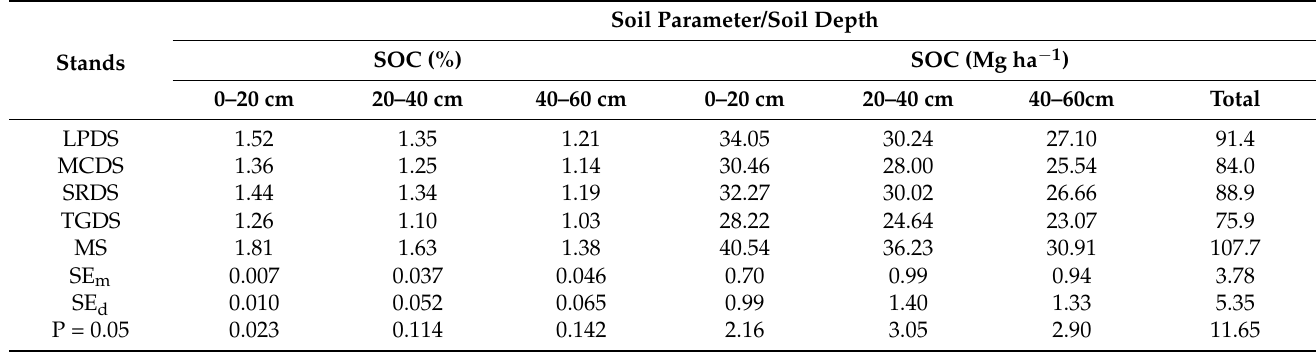
Table 7. SOC content and amount in the forest